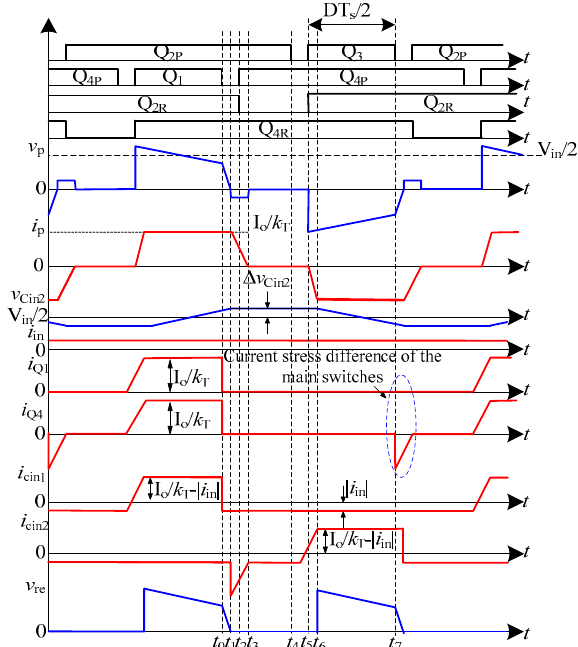
Figure 3. Key Figure 3. Key waveforms.